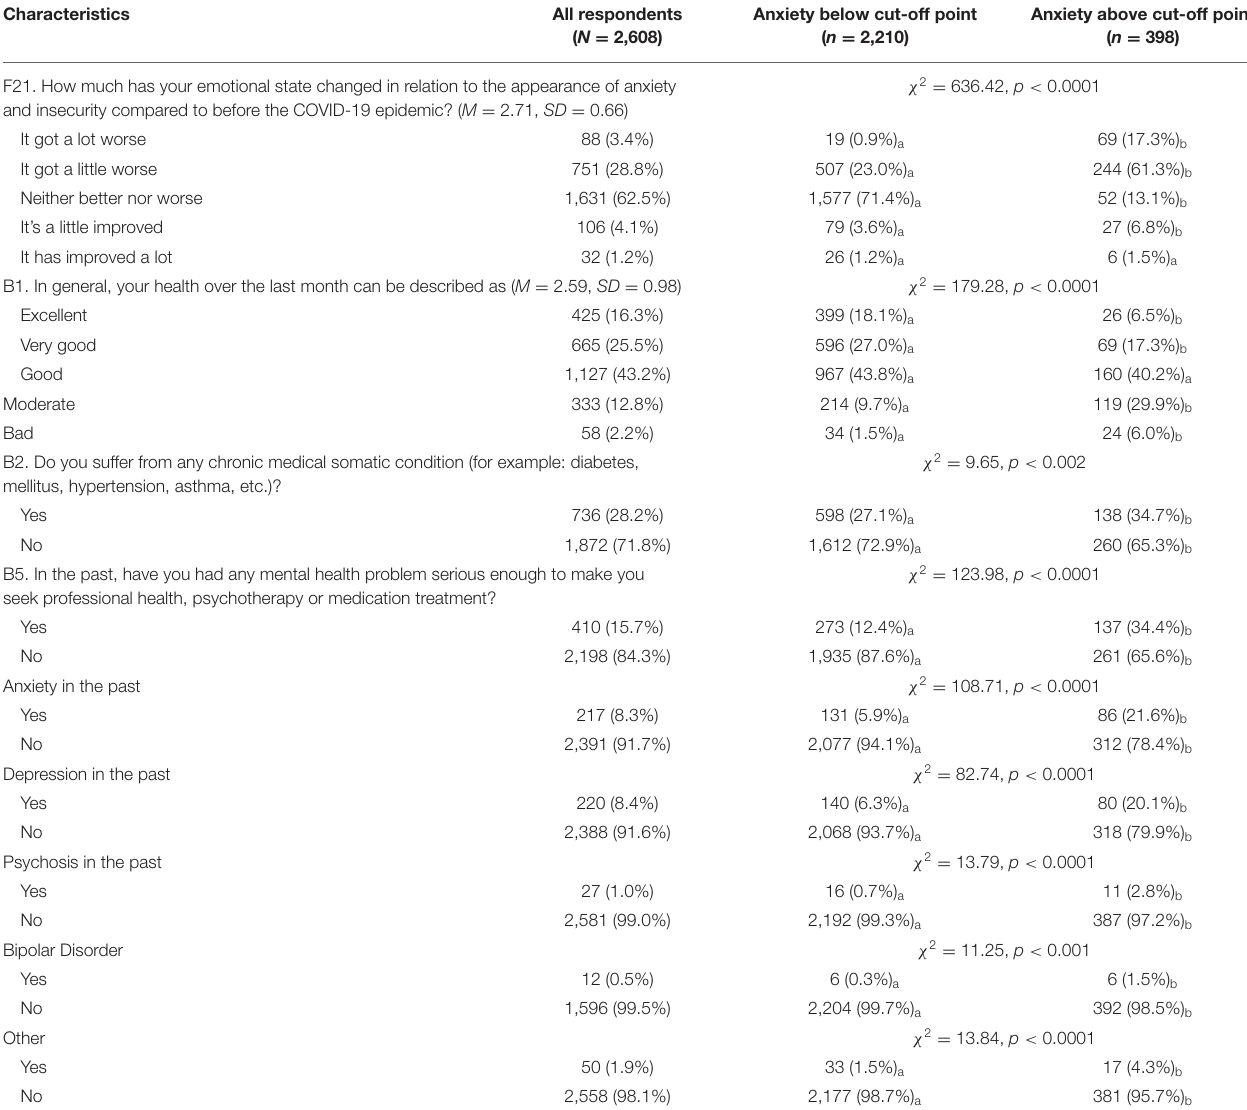
TABLE 2 | Health-Related determinants of anxiety ( n = 2,608). Characteristics All respondents